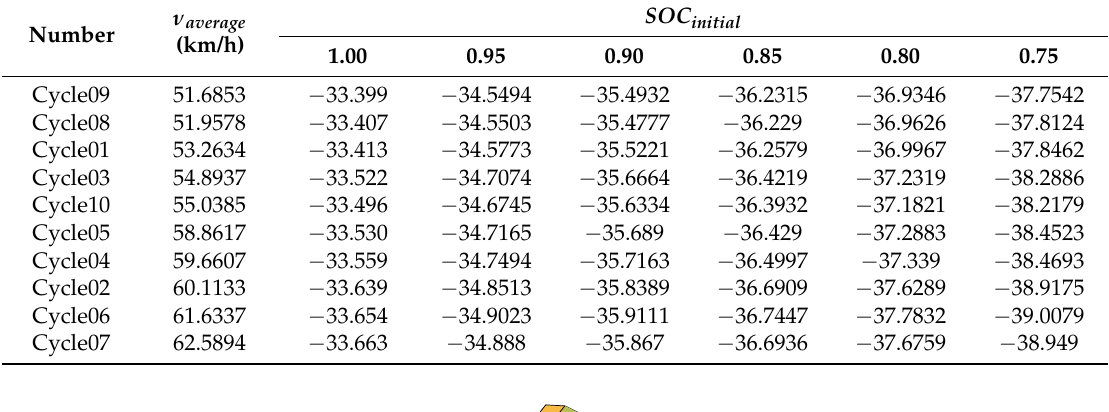
Table 3. λ 0 solving results by using the equal distance process.